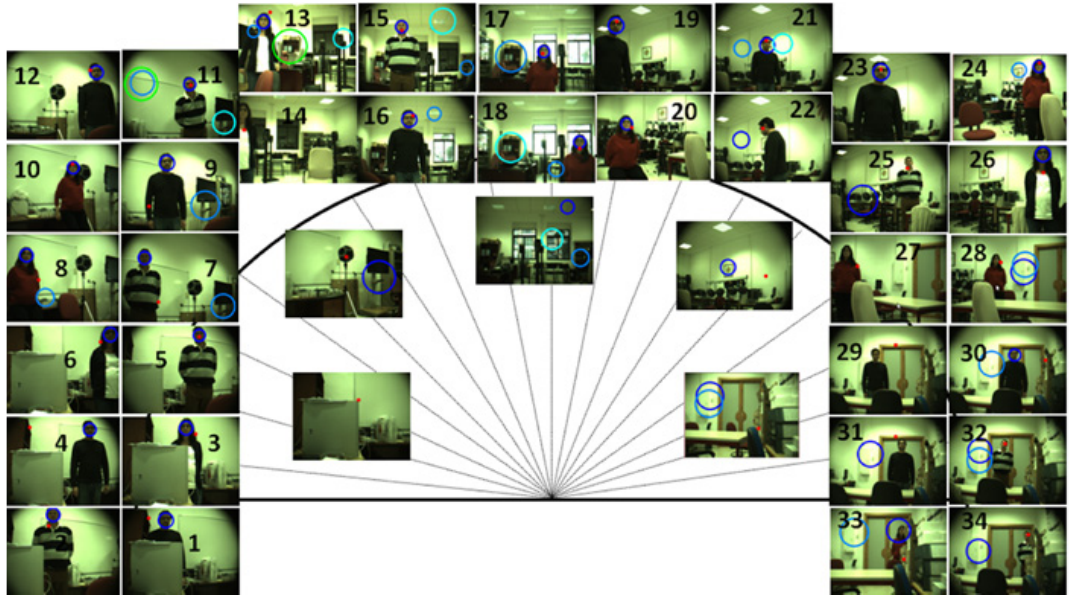
Figure 6. Visual localization system performance compared to a face-detector algorithm in five different backgrounds displayed in the images placed inside the circumference. The red circle on the image represents the visual system estimation. Blue circumferences show OpenCV face-detector